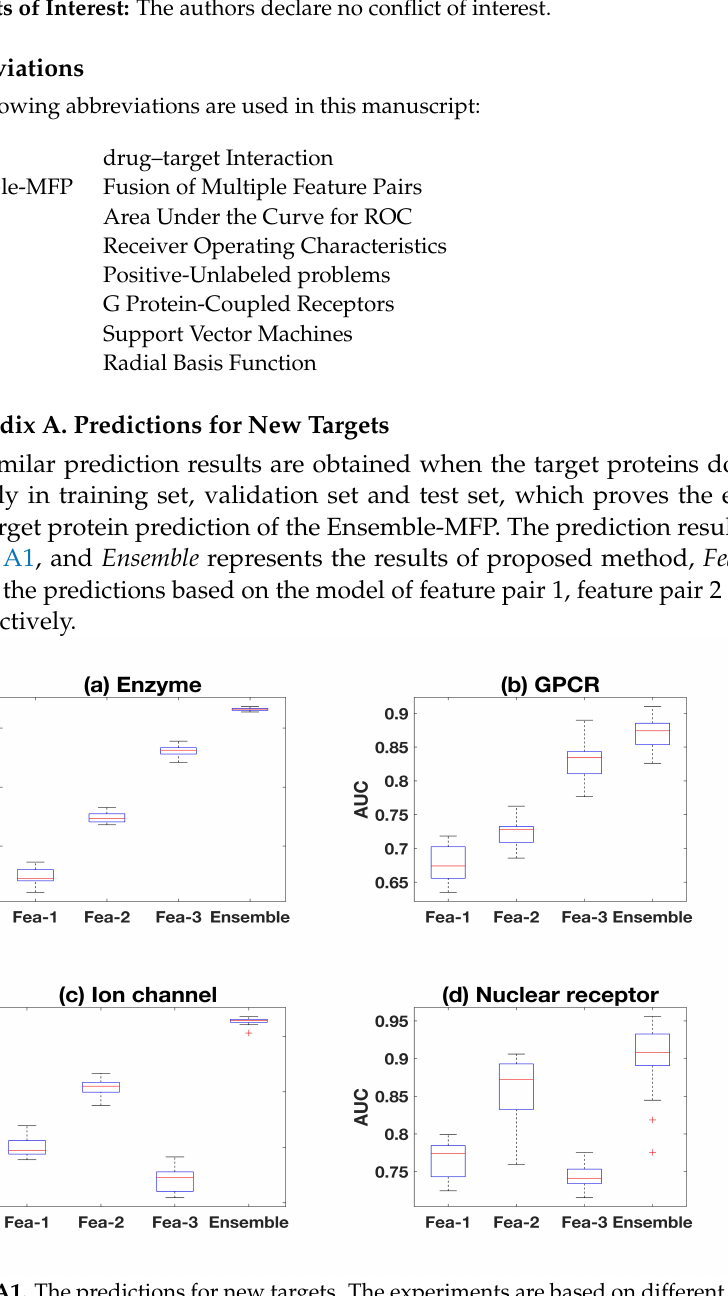
Figure A1. The predictions for new targets. The experiments are based on different targets of training set, validation set and test